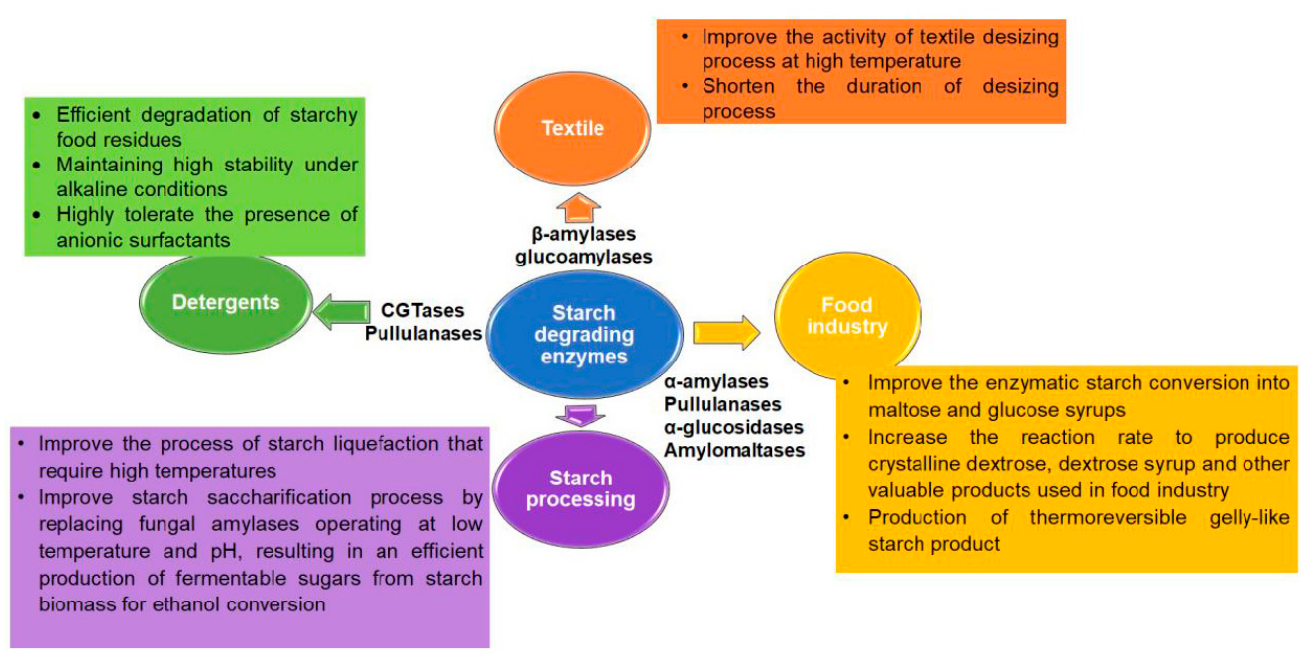
Figure 3. Applications of starch-degrading enzymes. The main applications of hyperthermophilic enzymes from different Archaea in specific industries are summarized in the given text box [8,34,38–41].